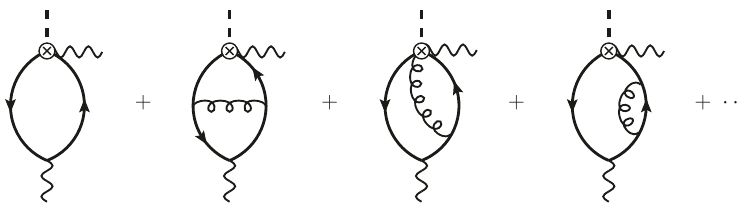
Figure 7 . Representative Feynman diagrams contributing to the matrix element h (cid:13)(cid:13) j O 2 ( z ) j h i up to O ( (cid:11) s ). We do not show mirror copies of the last two graphs, in which the gluon is attached to the other